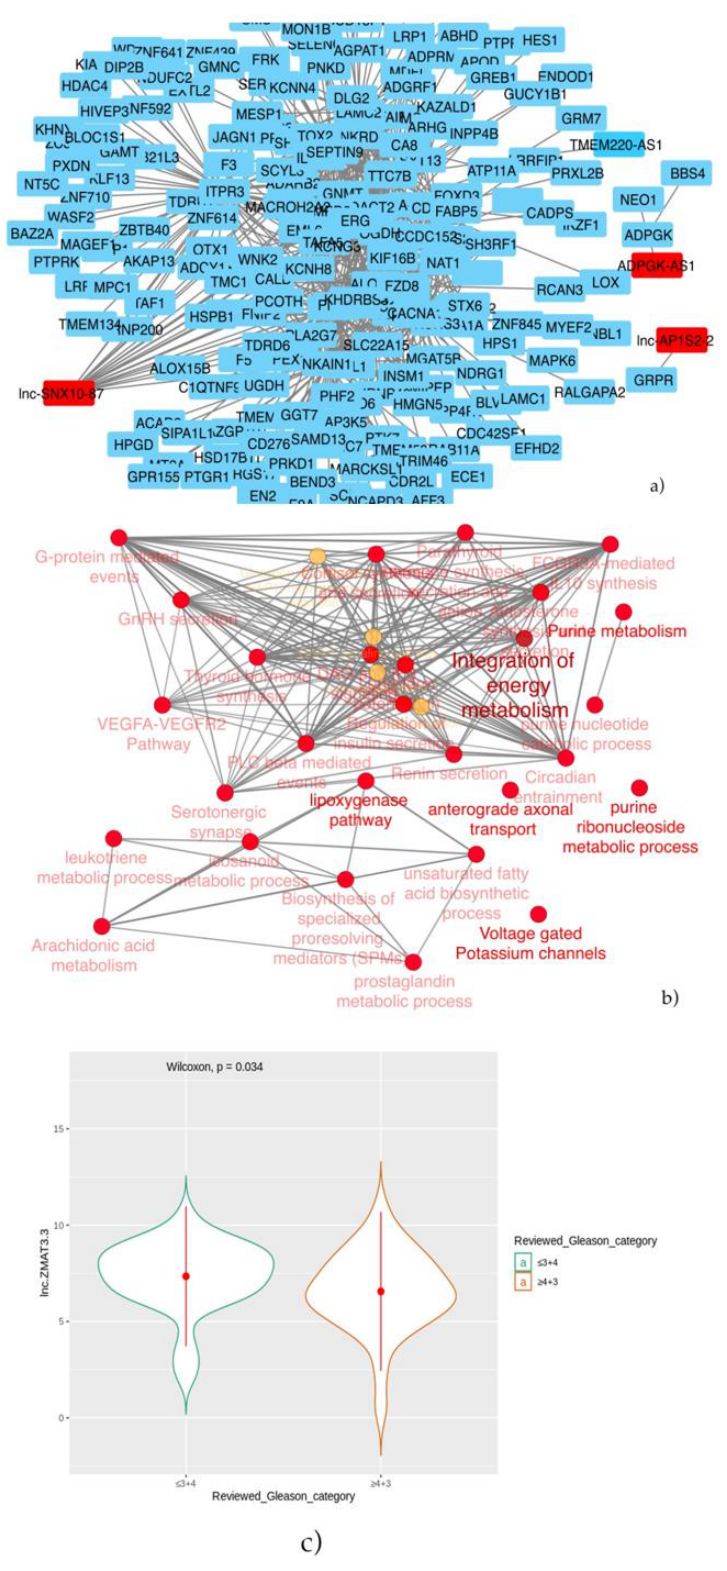
Figure 8. ( a ) Co-expression network, including significant correlations between lncRNAs/coding genes (red cells indicate lncRNAs with significant co-expression with genes) and ( b ) their functional enrichments. ( c ) Violin plot that shows that low-grade not-classified patients overexpress